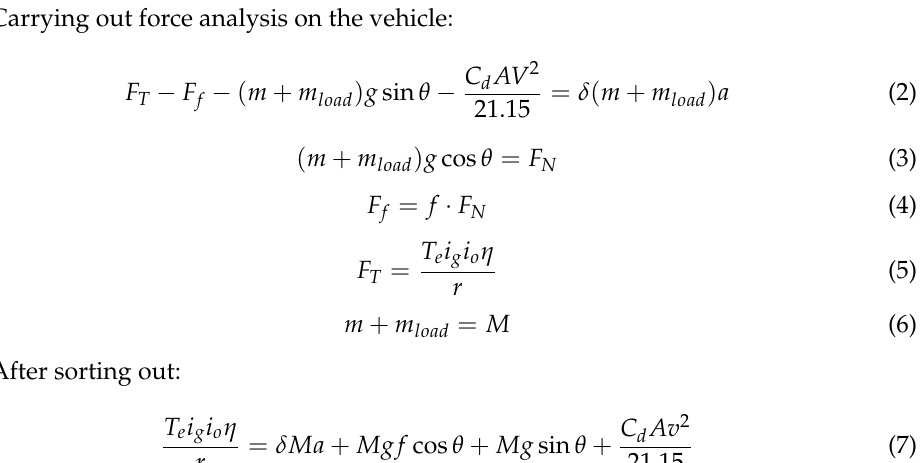
Figure 4. The vehicle dynamics analysis.